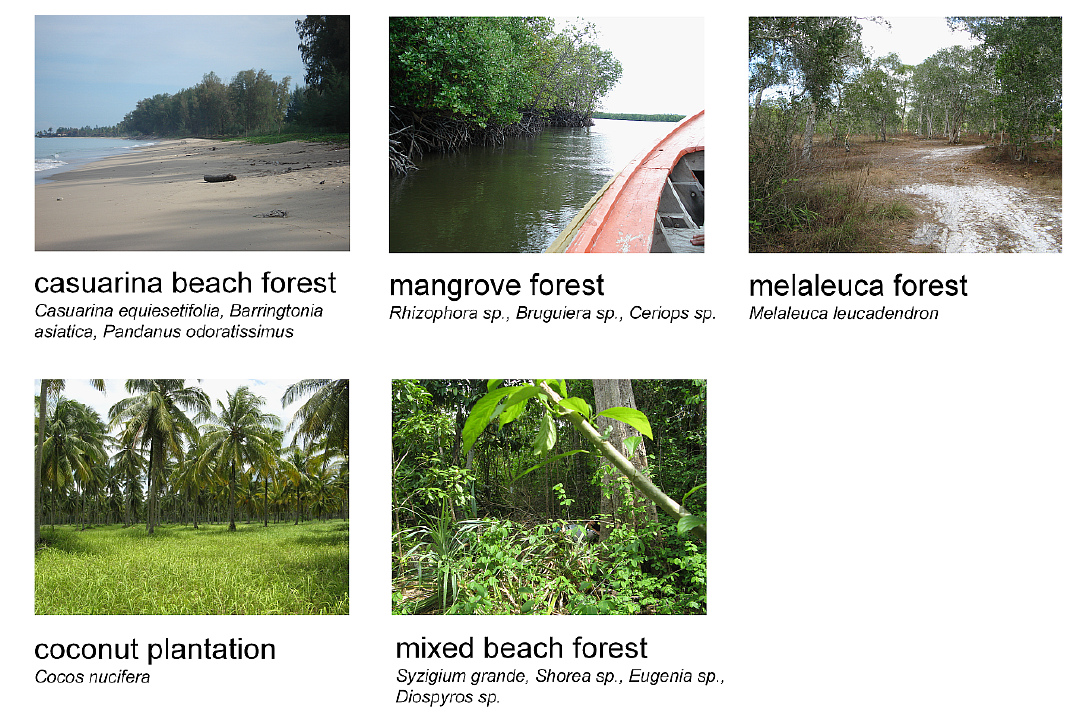
Fig. 2. Coastal forest ecosystems examined in the study (photos taken in January